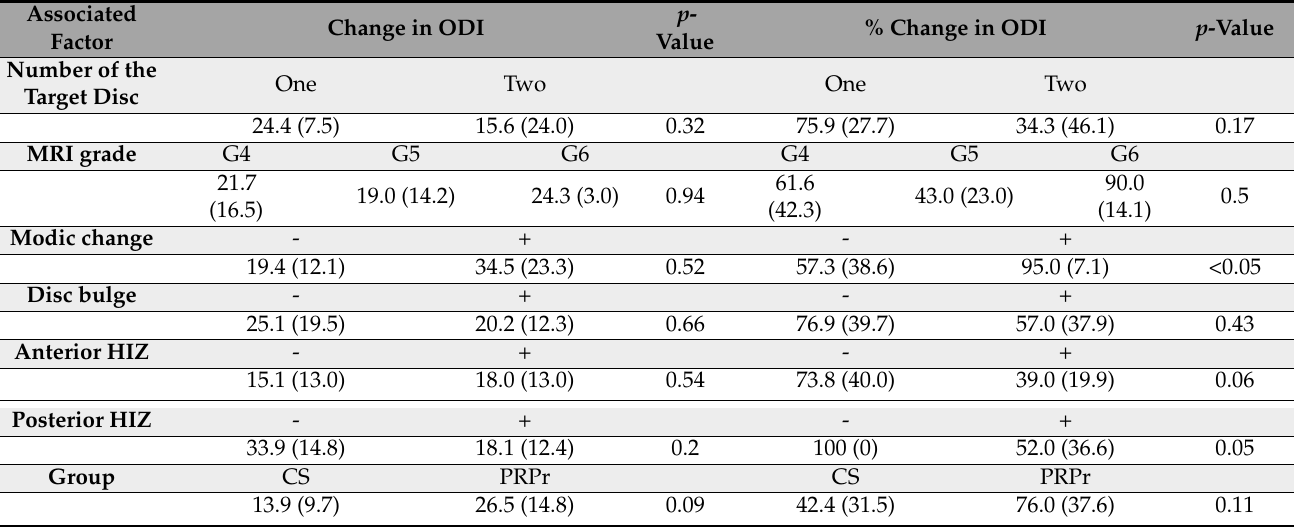
Table 3. Factors associated with ODI.